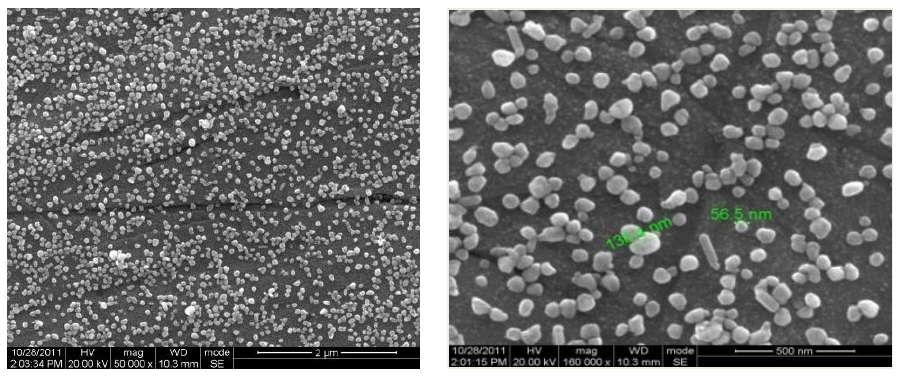
Figure 4. The SEM images of the as-prepared silver